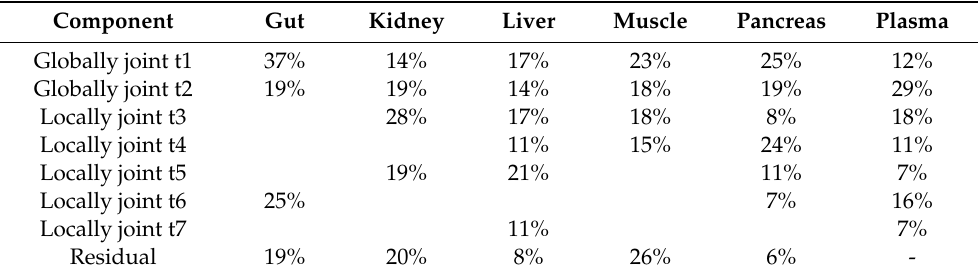
Table 1. Model component overview. These percentages represent the amount of compartment variation that is explained by each component. For example, the first globally joint component explained 37% of the variation in the